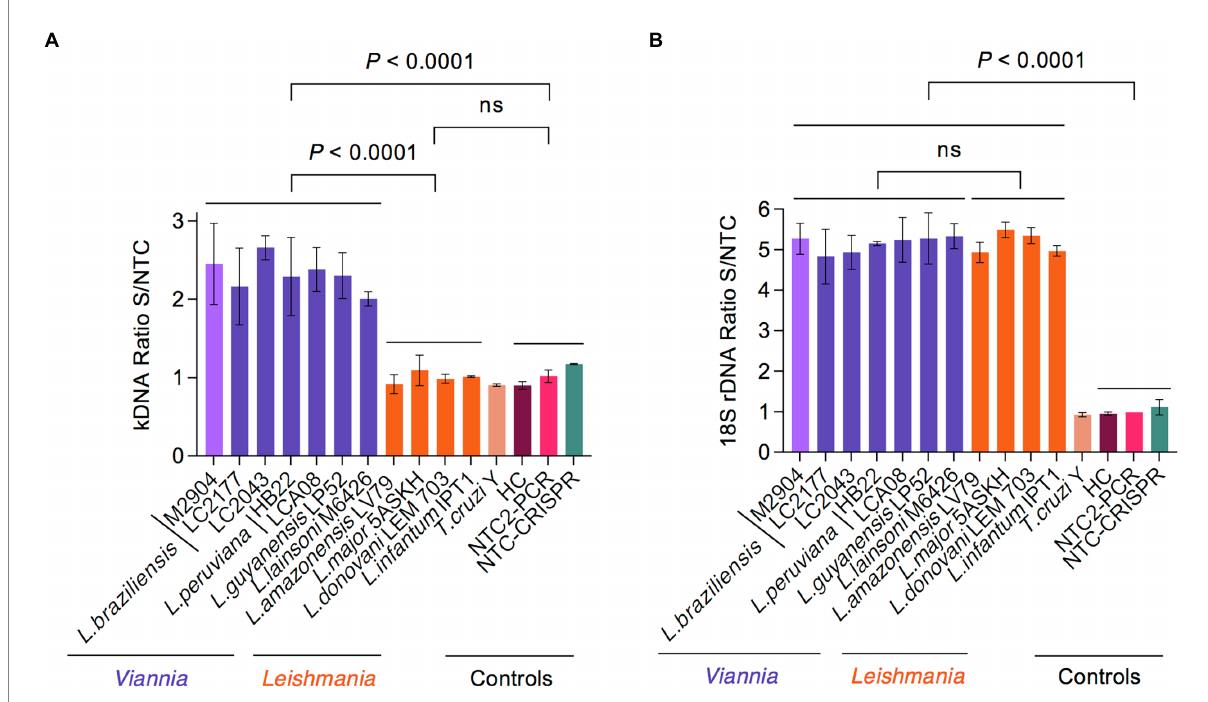
FIGURE 4 Analytical specificity of Cas12a-based detection of Leishmania spp. using reference strains. (A) The specificity of the kDNA PCR/CRISPR assay was evaluated using gDNA (preamplified with kDNA primer set 1) from 11 Leishmania strains (7 of subgenus Viannia and 4 of subgenus Leishmania ) and the T. cruzi Y strain. (B) The same DNA samples from reference strains as in (A) were tested in the specificity assessment of the 18S PCR/CRISPR assay using the 18S primer set 3 in the preamplification step. Bar graphs depict the fluorescence ratio from Cas12a reactions. Data are represented as mean ± SD ( n = 2 independent amplification and detection runs). Statistical comparisons between groups were conducted using an unpaired t -test (two-tailed p values are shown; non-significant p values are indicated by ns). Negative controls included human PBMC gDNA and NTC controls of PCR and CRISPR reactions. Fluorescence measurements of Cas12a detection runs were taken on the Synergy H1 plate reader. See Supplementary Figure S3 for the full time course